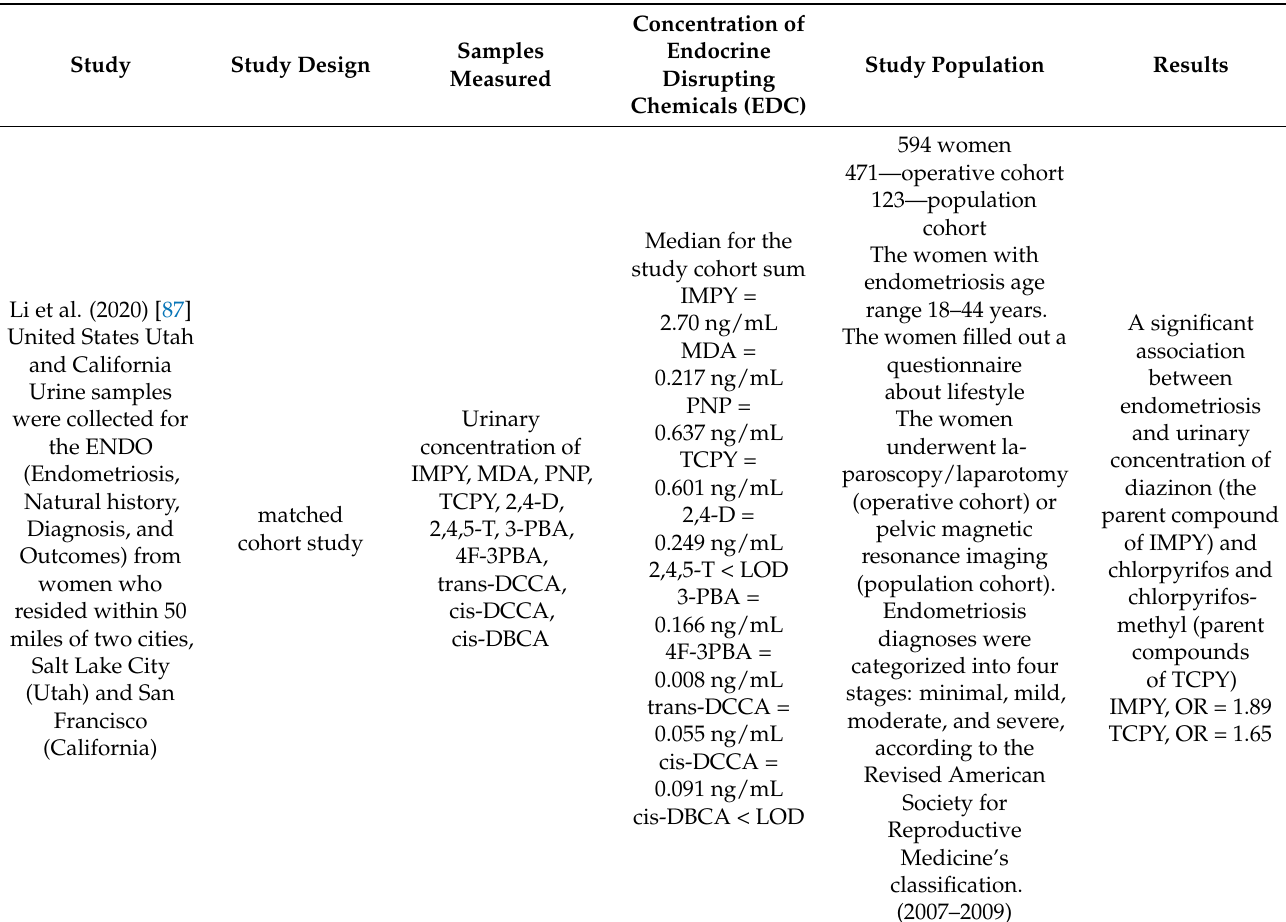
Table 5. Exposure to nonpersistent pesticides and